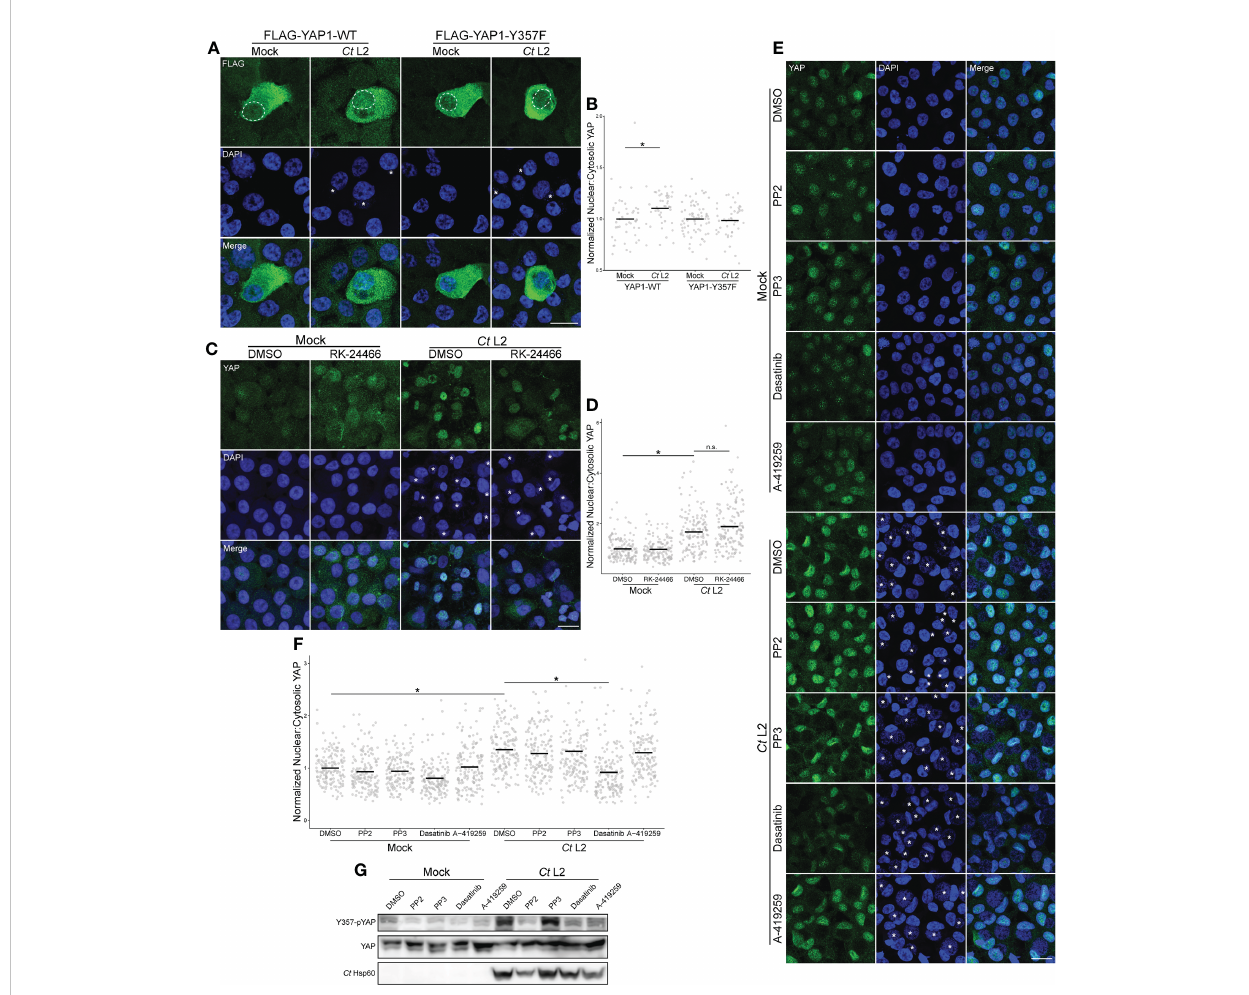
FIGURE 4 Infection-induced phosphorylation at Y357 is required for YAP nuclear translocation. (A) Representative micrographs of the translocation of FLAG- tagged YAP wild-type or the phospho-dead Y357F mutant (green) into the nuclei (blue) of con fl uent mock- and Ct L2-infected End1 cells at 24 hpi. Asterisks: chlamydial inclusions, scale bar: 20 m m, dotted lines: nuclear area of transfected cells. (B) Quanti fi cation of YAP nuclear translocation in (A) . n = 3 biological replicates, 50 cells measured per sample. Black bars: group means; asterisks: p-values ≤ 0.05, using pairwise Wilcoxon rank sum tests and Bonferroni ’ s correction for multiple comparisons. (C) Representative micrographs of YAP translocation at 24 hpi in con fl uent mock- and Ct L2-infected End1 cells treated with the Lck inhibitor RK-24466 (10 nM for 24 h), or DMSO. Asterisks: chlamydial inclusions, scale bar: 20 m m. (D) Quanti fi cation of YAP nuclear translocation in (C) . n = 3 biological replicates, 50 cells measured per sample. Black bars: group means; asterisks: p-values ≤ 0.05, using pairwise Wilcoxon rank sum tests and Bonferroni ’ s correction for multiple comparisons. (E) Representative micrographs of YAP translocation at 24 hpi in con fl uent mock- and Ct L2-infected End1 cells treated with the Src-family kinase (SFK) inhibitor PP2 (10 m M for 24 h), the inactive PP2 variant PP3 (10 m M for 24 h), the SFK/Abl inhibitor dasatinib (1 m M for 1 h), the SFK inhibitor A-419259 (1 m M for 5h), or DMSO. Asterisks: chlamydial inclusions, scale bar: 20 m m. (F) Quanti fi cation of YAP nuclear translocation in (E) . n = 3 biological replicates, 50 cells measured per sample. Black bars: group means; asterisks: p-values ≤ 0.05, using pairwise Wilcoxon rank sum tests and Bonferroni ’ s correction for multiple comparisons. (G) Representative Western blot of YAP tyrosine phosphorylation of mock- and Ct L2-infected End1 cells at 24 hpi, treated with the SFK inhibitor PP2 (10 m M for 24 h), the inactive PP2 variant PP3 (10 m M for 24 h), the SFK/Abl inhibitor dasatinib (1 m M for 1 h), the SFK inhibitor